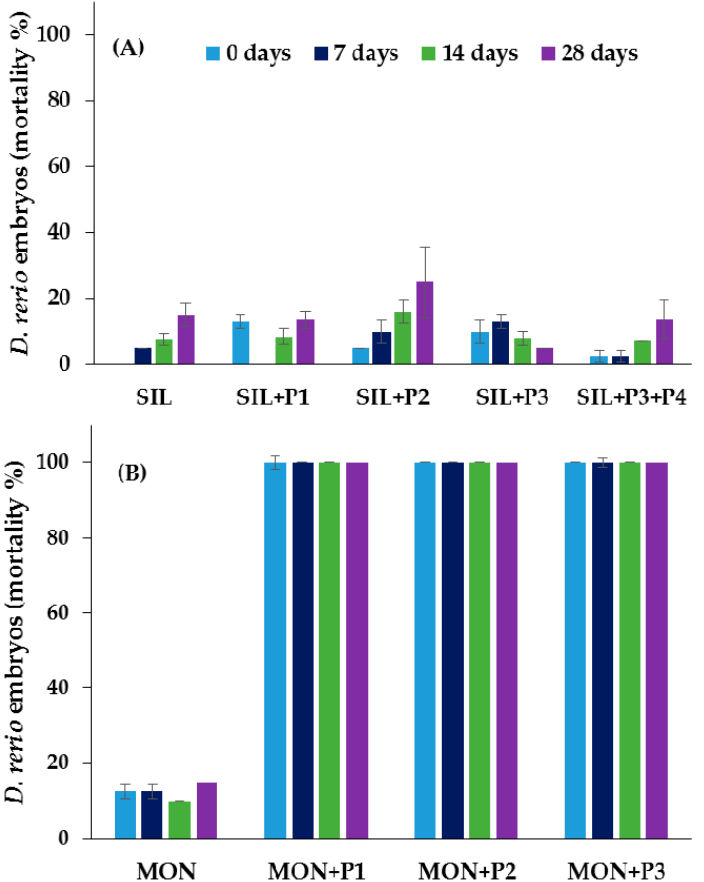
Figure 4. Fish Embryo Toxicity (FET) test at 96h of exposure of Danio rerio embryos to soil water extracts from ( A ) SIL and ( B ) and MON mesocosms. SIL: sandy-silty-clay soil; MON: gravel in a sandy-silty soil. P1, P2, P3, P4: foaming agent products.